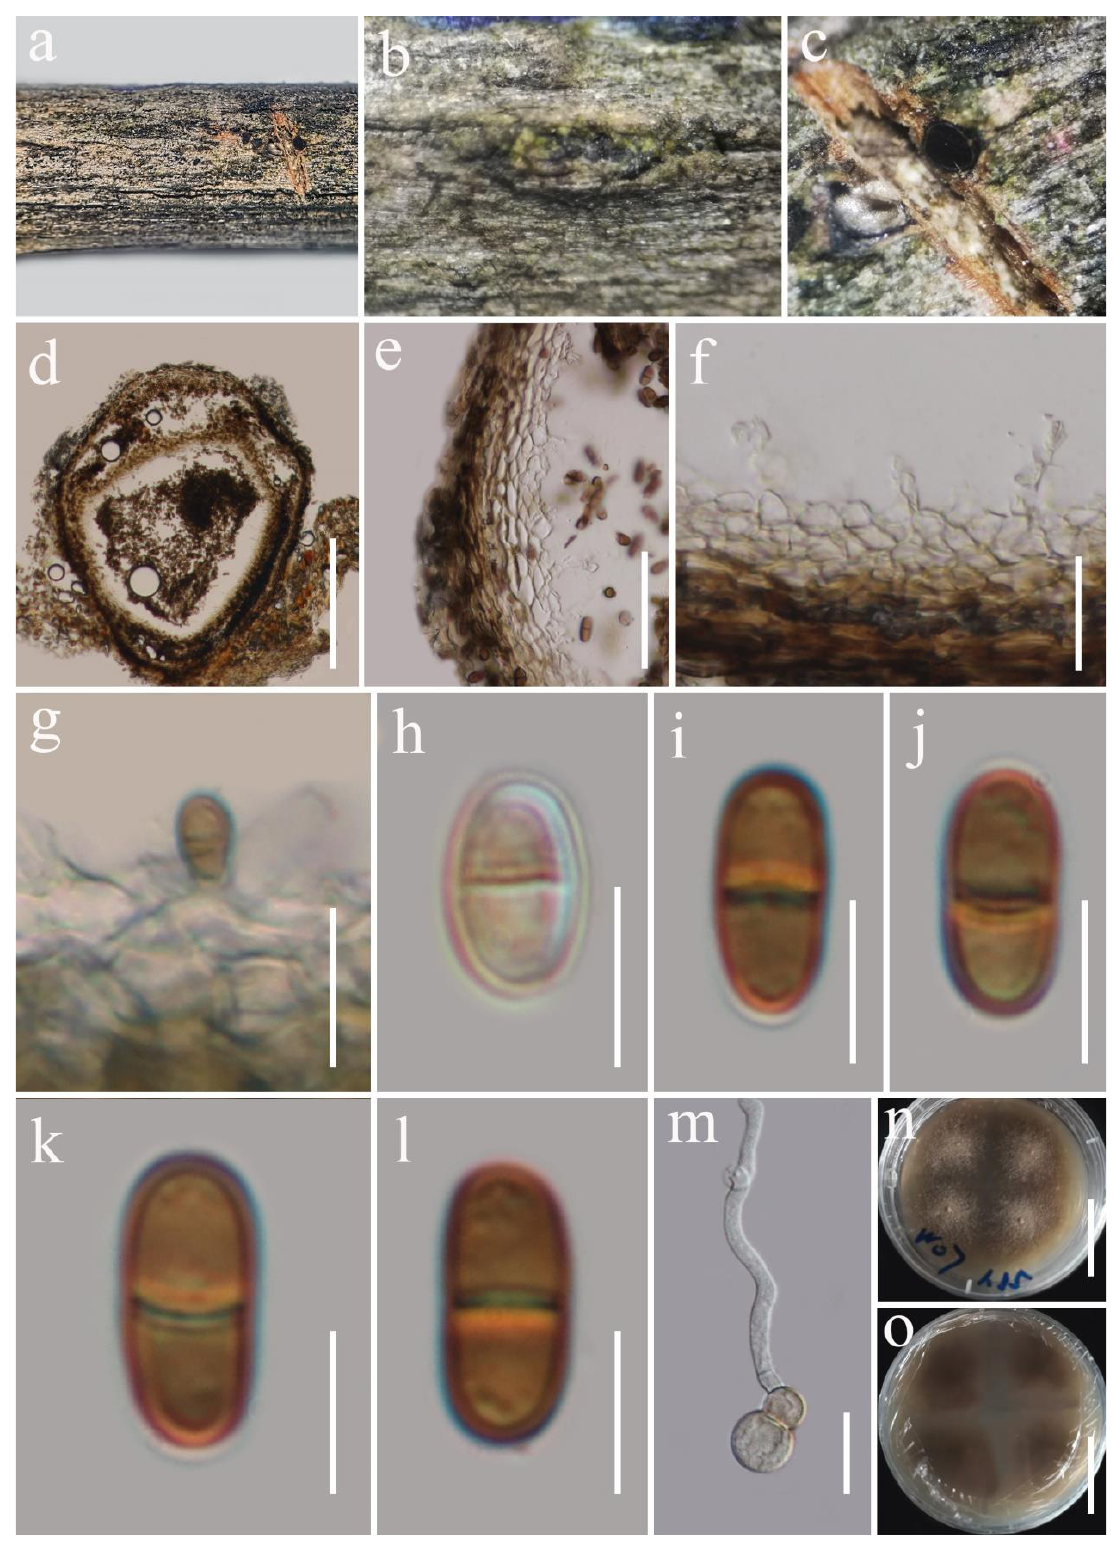
Figure 6. Karstenula lancangensis (HKAS 122790, holotype). ( a – c ) Conidiomata on the natural wood surface; ( d , e ) sections through conidiomata; ( f ) conidioma wall; ( g ) conidiogenous cells and developing conidia; ( h – l ) conidia; ( m ) germinated conidium; ( n , o ) culture characters on PDA. Scale bars, ( d ) 200 μm; ( e ) 40 μm; ( f ) 20 μm; ( g ) 10 μm; ( h – m ) 5 μm; ( n , o ) 30 mm. Montagnula Berl., Icon. fung. (Abellini) 2: 68 (1896). Montagnula was introduced by Berlese [99], with M. infernalis as the type species. Currently, 39 Montagnula species are accepted [45], with cosmopolitan distribution [27].